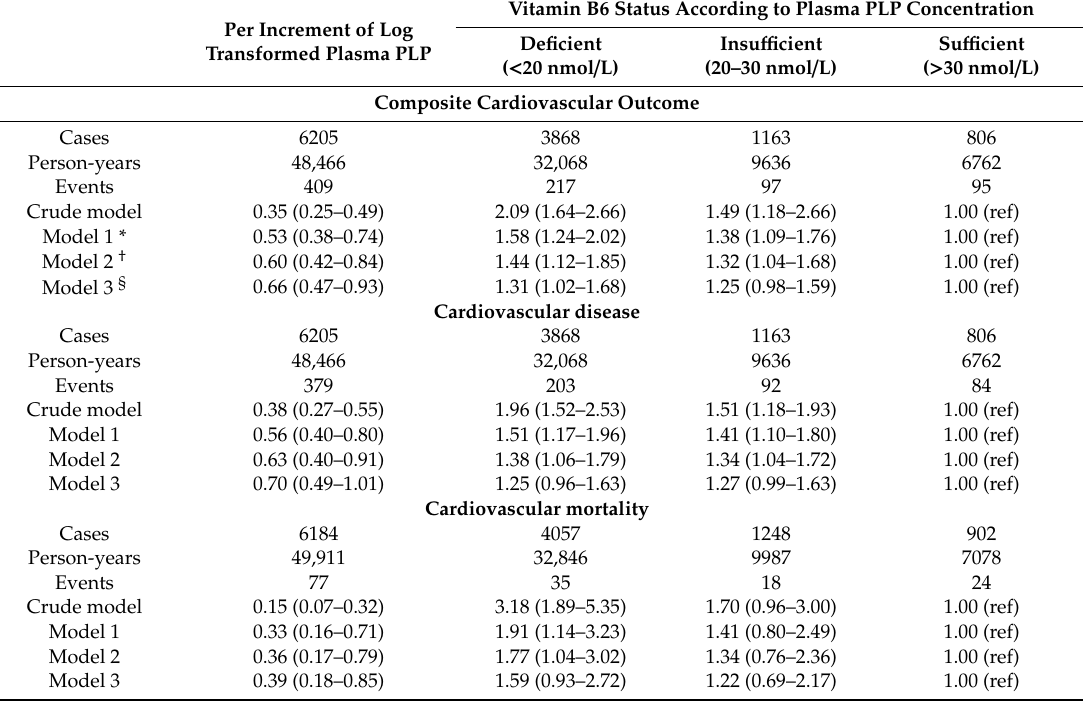
Table 2. Hazard ratios for the associations between plasma pyridoxal 5’-phosphate and vitamin B6 status and cardiovascular outcome, with adjustment for potential